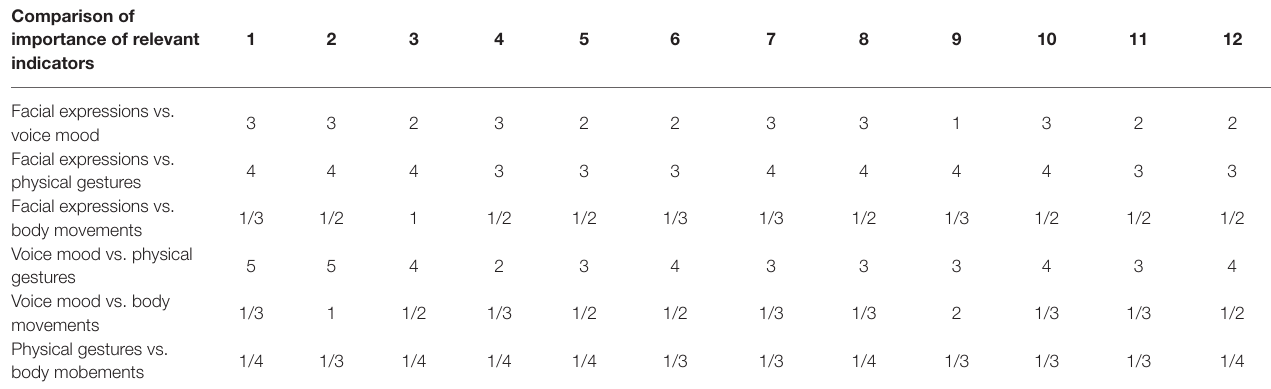
TABLE 3 | Original data of valid samples.